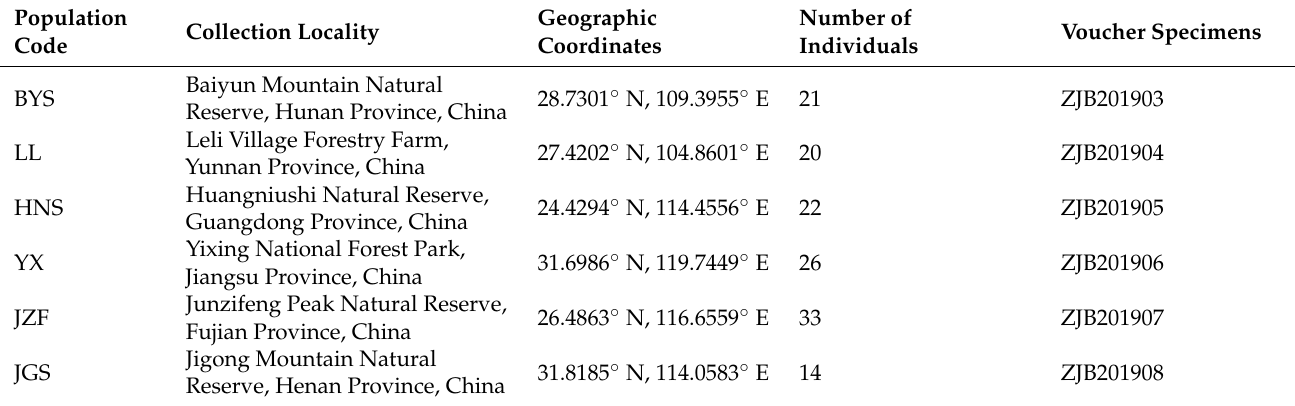
Table 6. Information of plant materials of S. tzumu collected in this